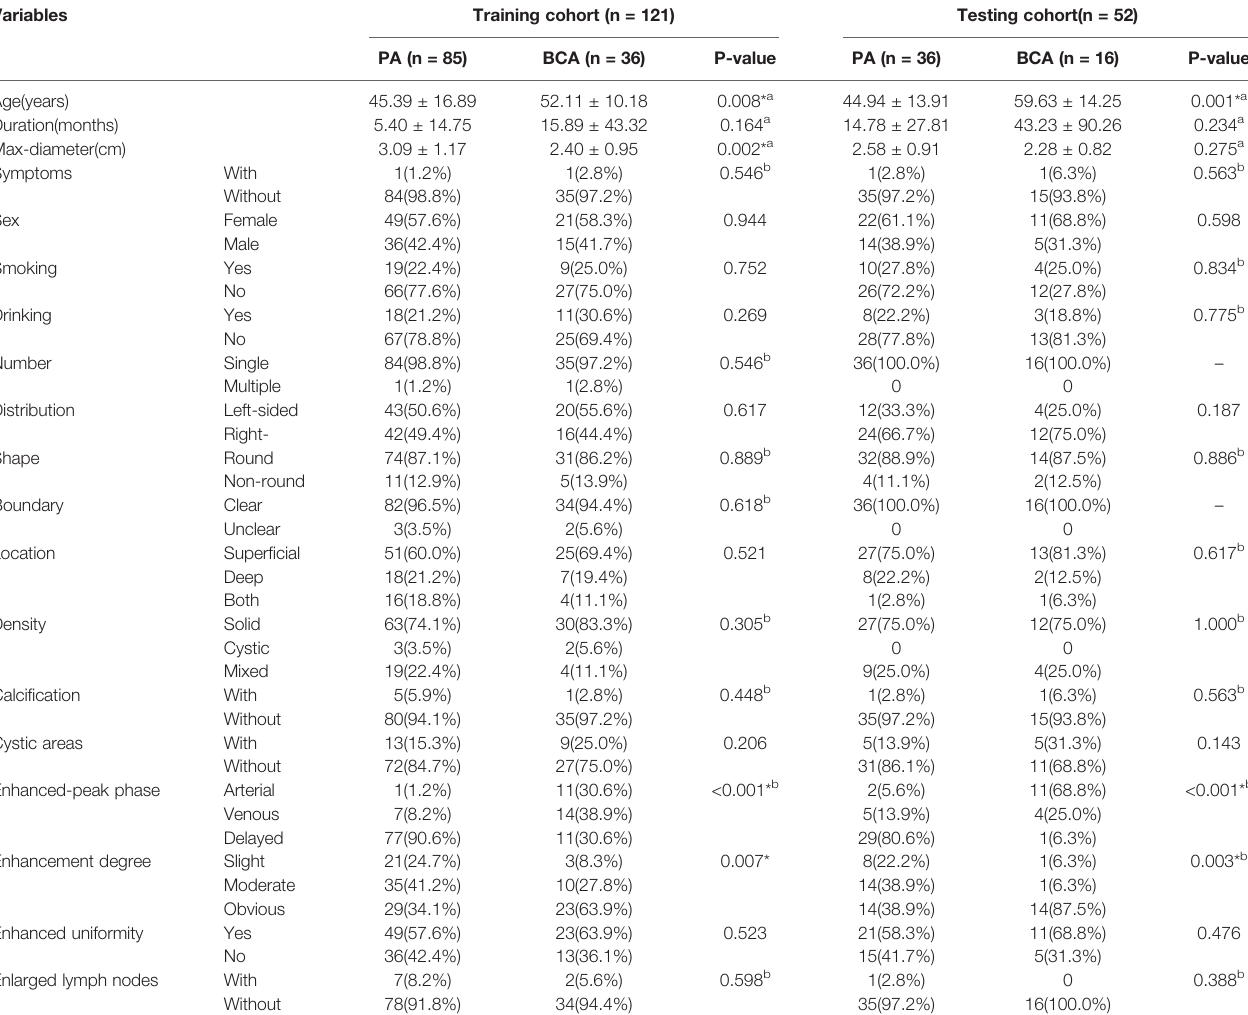
TABLE 3 | Clinical and radiological characteristics in the training and testing cohorts.